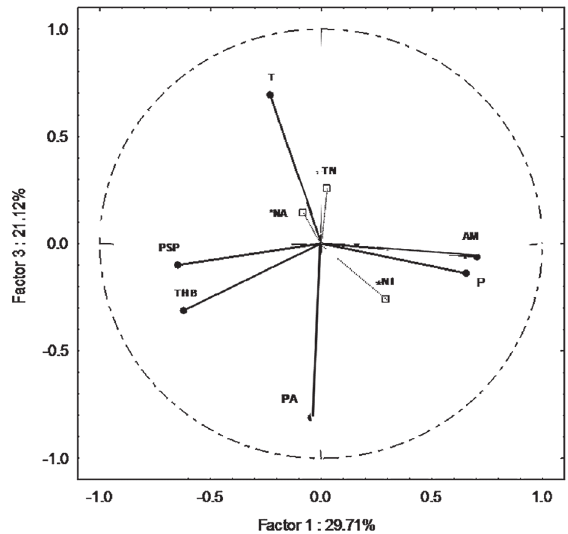
Figure 2 - PCA analysis (factors 1 and 3) highlighting main (black circles) and supplementary (white squares)